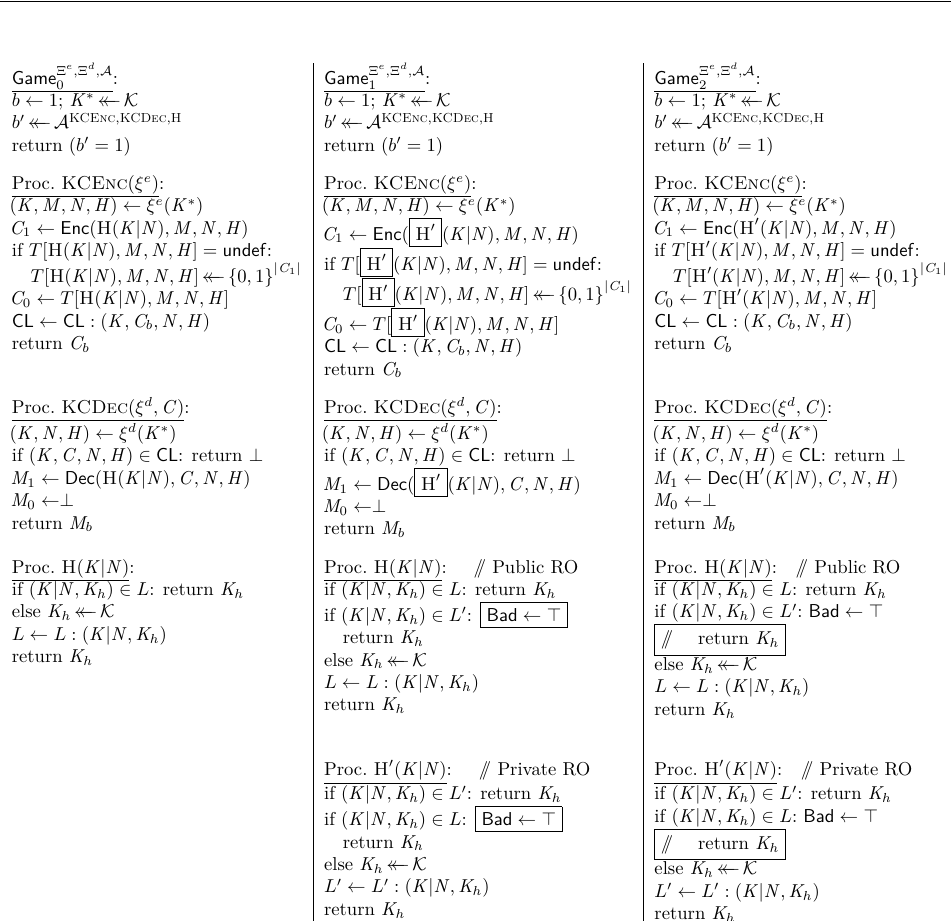
Figure 8: Game 0 shows the KC-AE game with respect to SE and challenge bit 1. Game 1 separates the lists for H and H 0 . There are no functional changes. Game 2 then fully decouples H and H 0